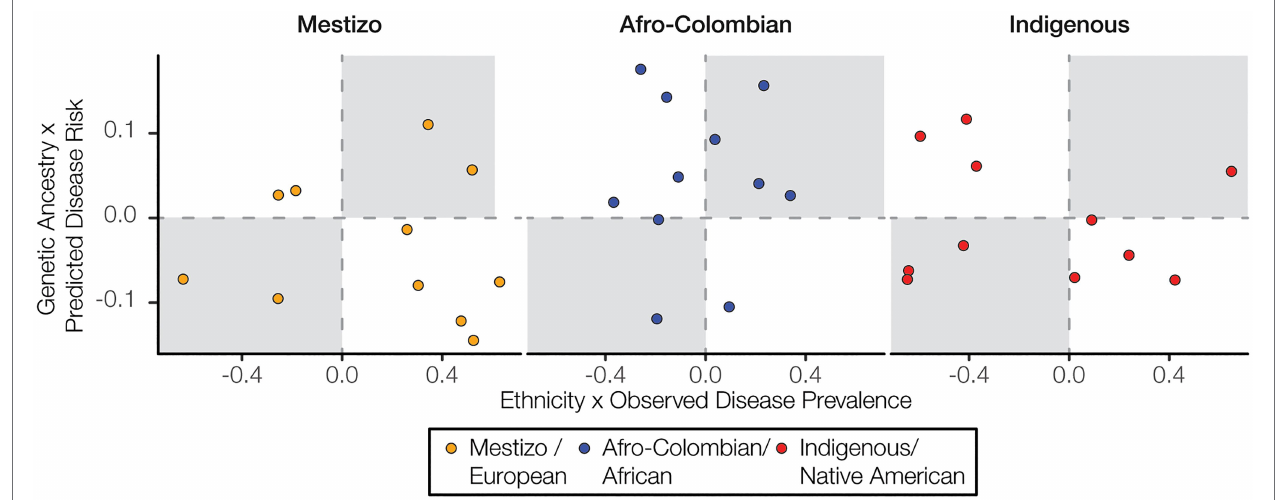
FIGURE 6 | Ethnicity and disease prevalence vs. genetic ancestry and disease risk. Correlation values for ethnicity and disease prevalence are plotted against correlation values for genetic ancestry and disease risk. Concordant correlations, both positive or both negative, are shown in the upper right and lower left quadrants, respectively.